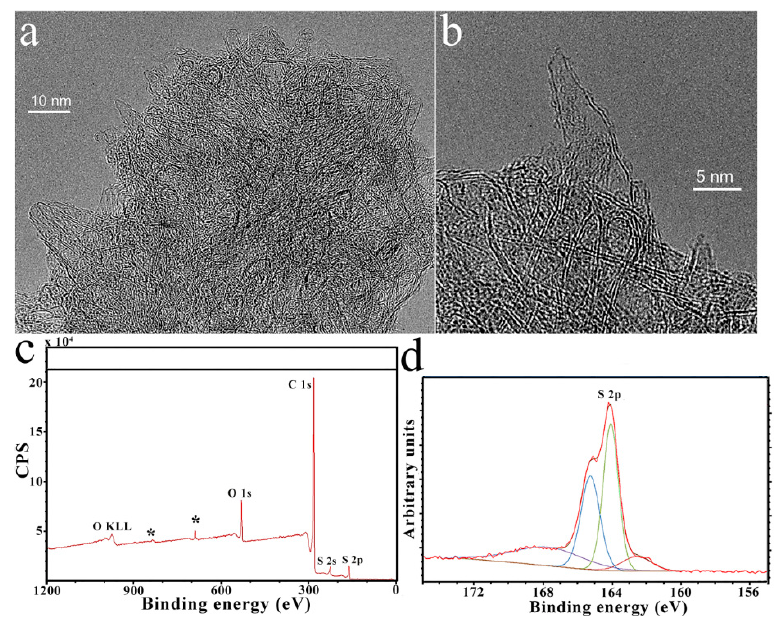
Figure 3. ( a , b ) HR-TEM micrographs showing the structure of S-CNHs. ( c ) XPS survey spectrum recorded on one of these S-CNHs samples, where S 2p , C 1s and O 1s are observed. Impurities <1% due to F are shown with *. ( d ) High-resolution S 2p XPS of S-CNHs. The peaks are fitted to four components centered at 162.2, 164.1, 165.3 and 168.4, corresponding to S p3/2 , S p3/2 , S p1/2 , and S-O, respectively.